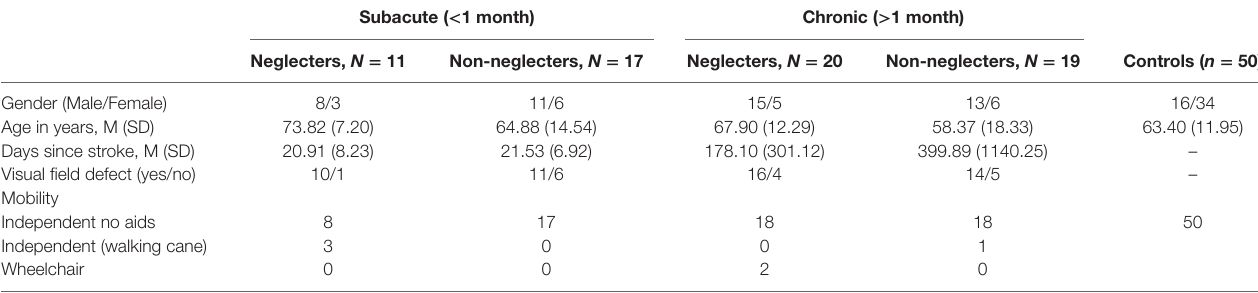
TaBle 1 | Group demographics divided by subacute and chronic stages of recovery for neglecters and non-neglecting right hemisphere damage